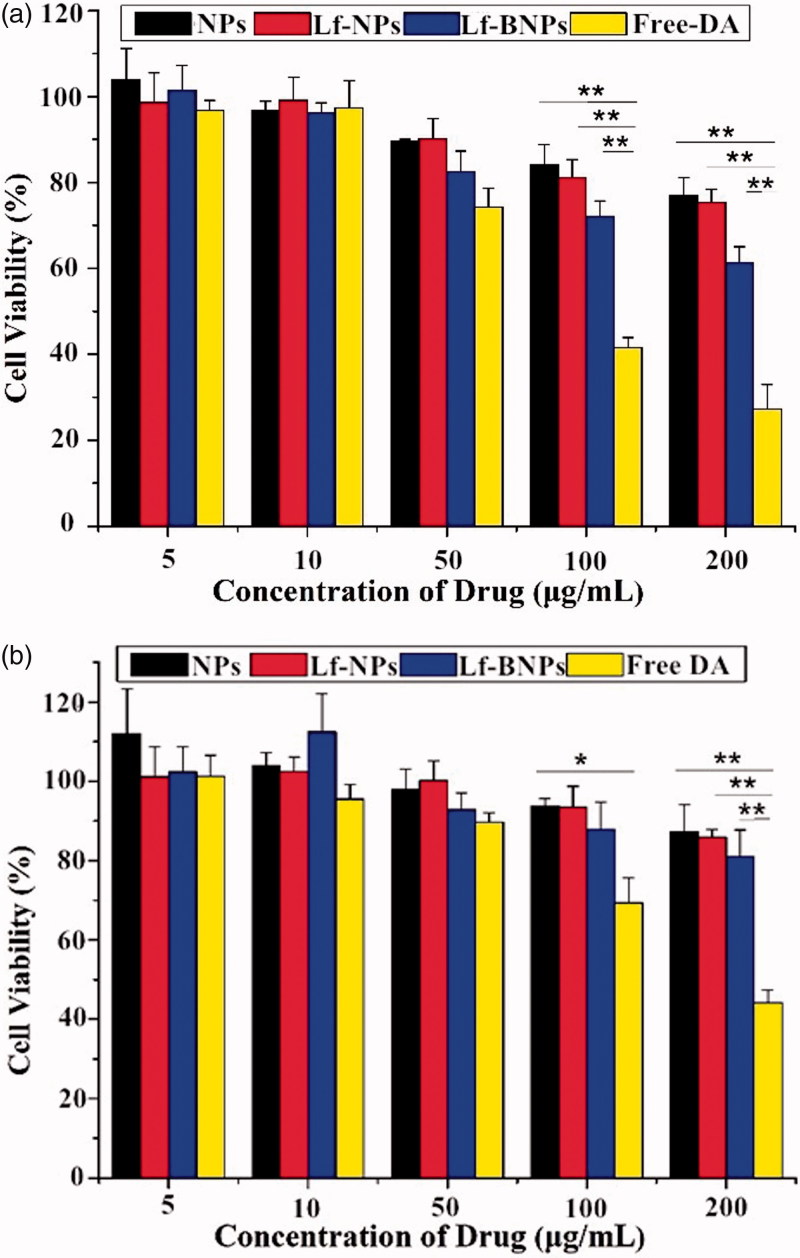
In vitro cytotoxicity of free dopamine and corresponding concentrations of dopamine-loaded NPs, Lf-NPs, and Lf-BNPs on 16HBE (a) and SH-SY5Y cells (b). Cells were exposed to different concentrations of free dopamine, NPs, Lf-NPs, and Lf-BNPs for 24 h and cell viability was measured. Values represent the mean ± SD (n = 3). *p < .05; **p < .01 (versus Free dopamine group).